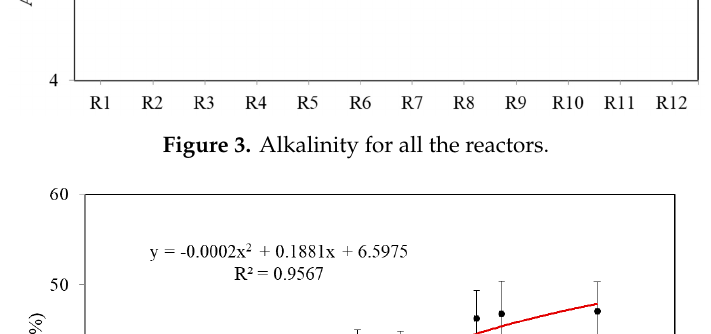
Figure 3. Alkalinity for all the reactors.